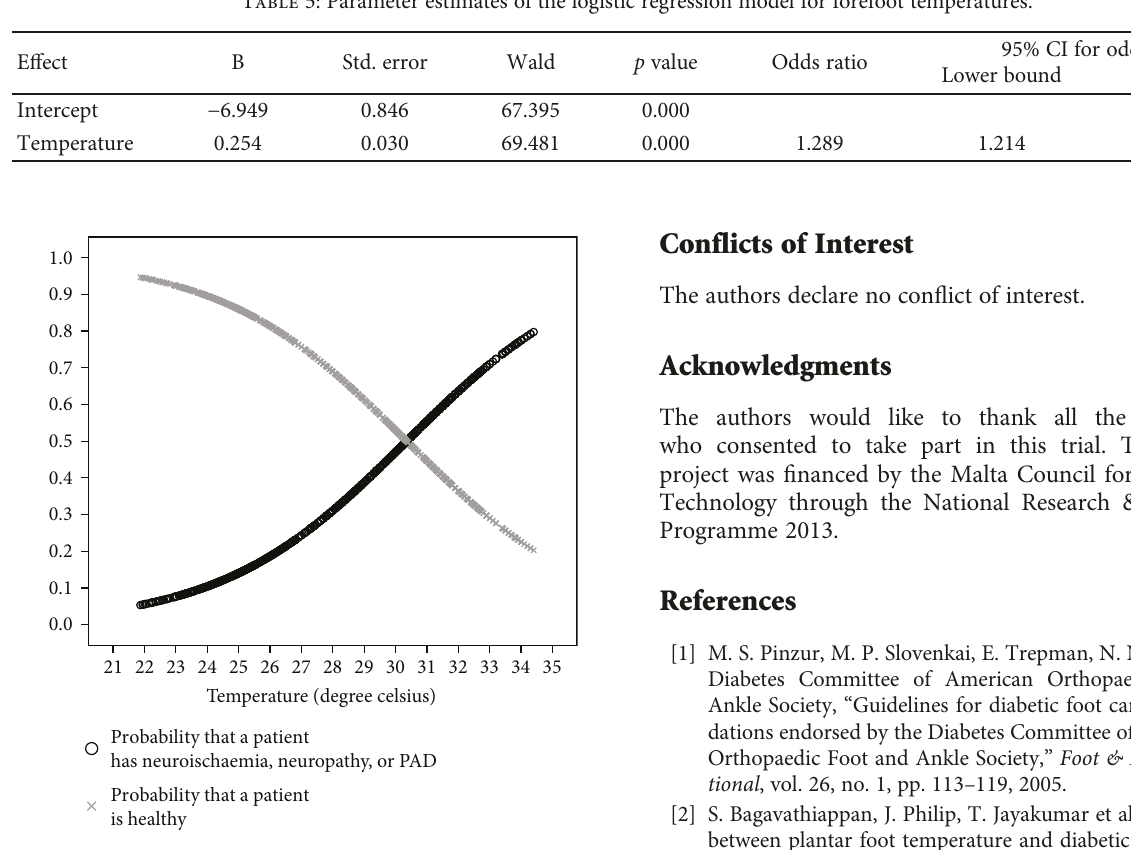
Figure 5: Logistical regression curves of forefoot